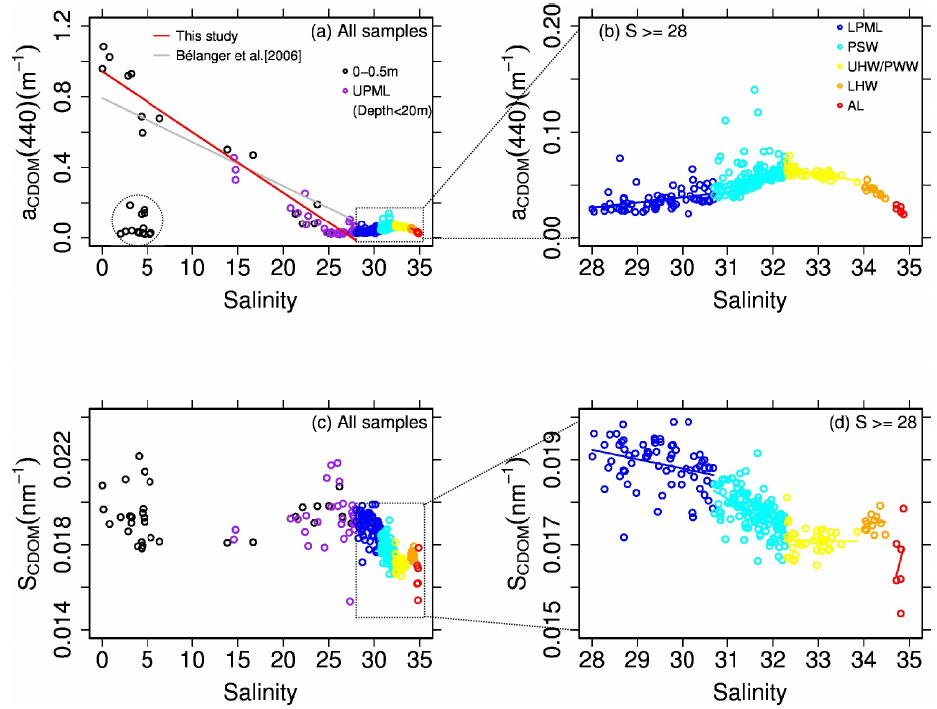
Fig. 5. Upper panels: a CDOM (440) as a function of salinity ( S ) for (a) the whole range and (b) S ≥ 28 (below the UPML). A linear fit provides the following relationship: a CDOM (440) = 0.943–0.034*S, N = 52; p < 0 . 0001. Data points which were influenced by sea ice melt are marked as a dotted circle. Lower panels: S CDOM as a function of S for (c) whole range and (d) S ≥ 28 (below the